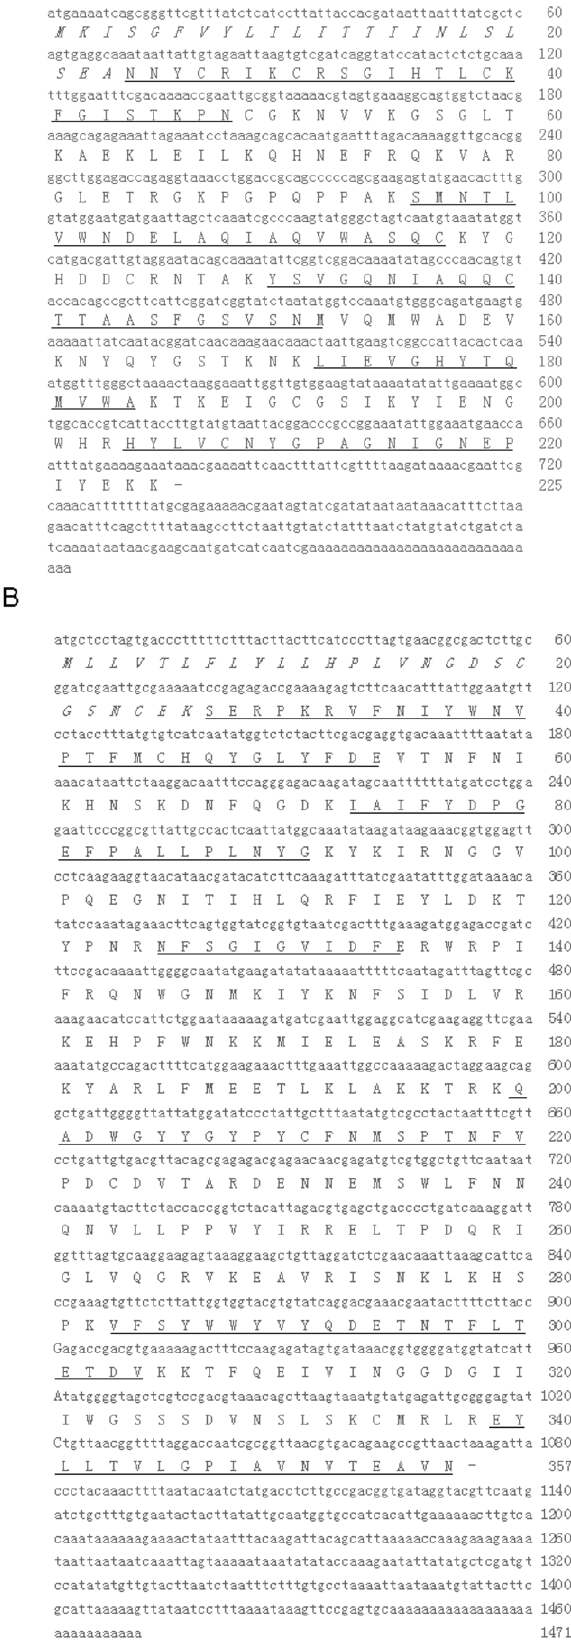
Figure 2. cDNA encoding the Vesp ma 5 (A) and Vesp ma 2 (B) from the wasp venom of V.magnifica and deduced amino acid sequence. The amino acid sequences of peptide fragments deter- mined by Edman degradation are underlined. The predicted signal peptide is in italic. -: stop